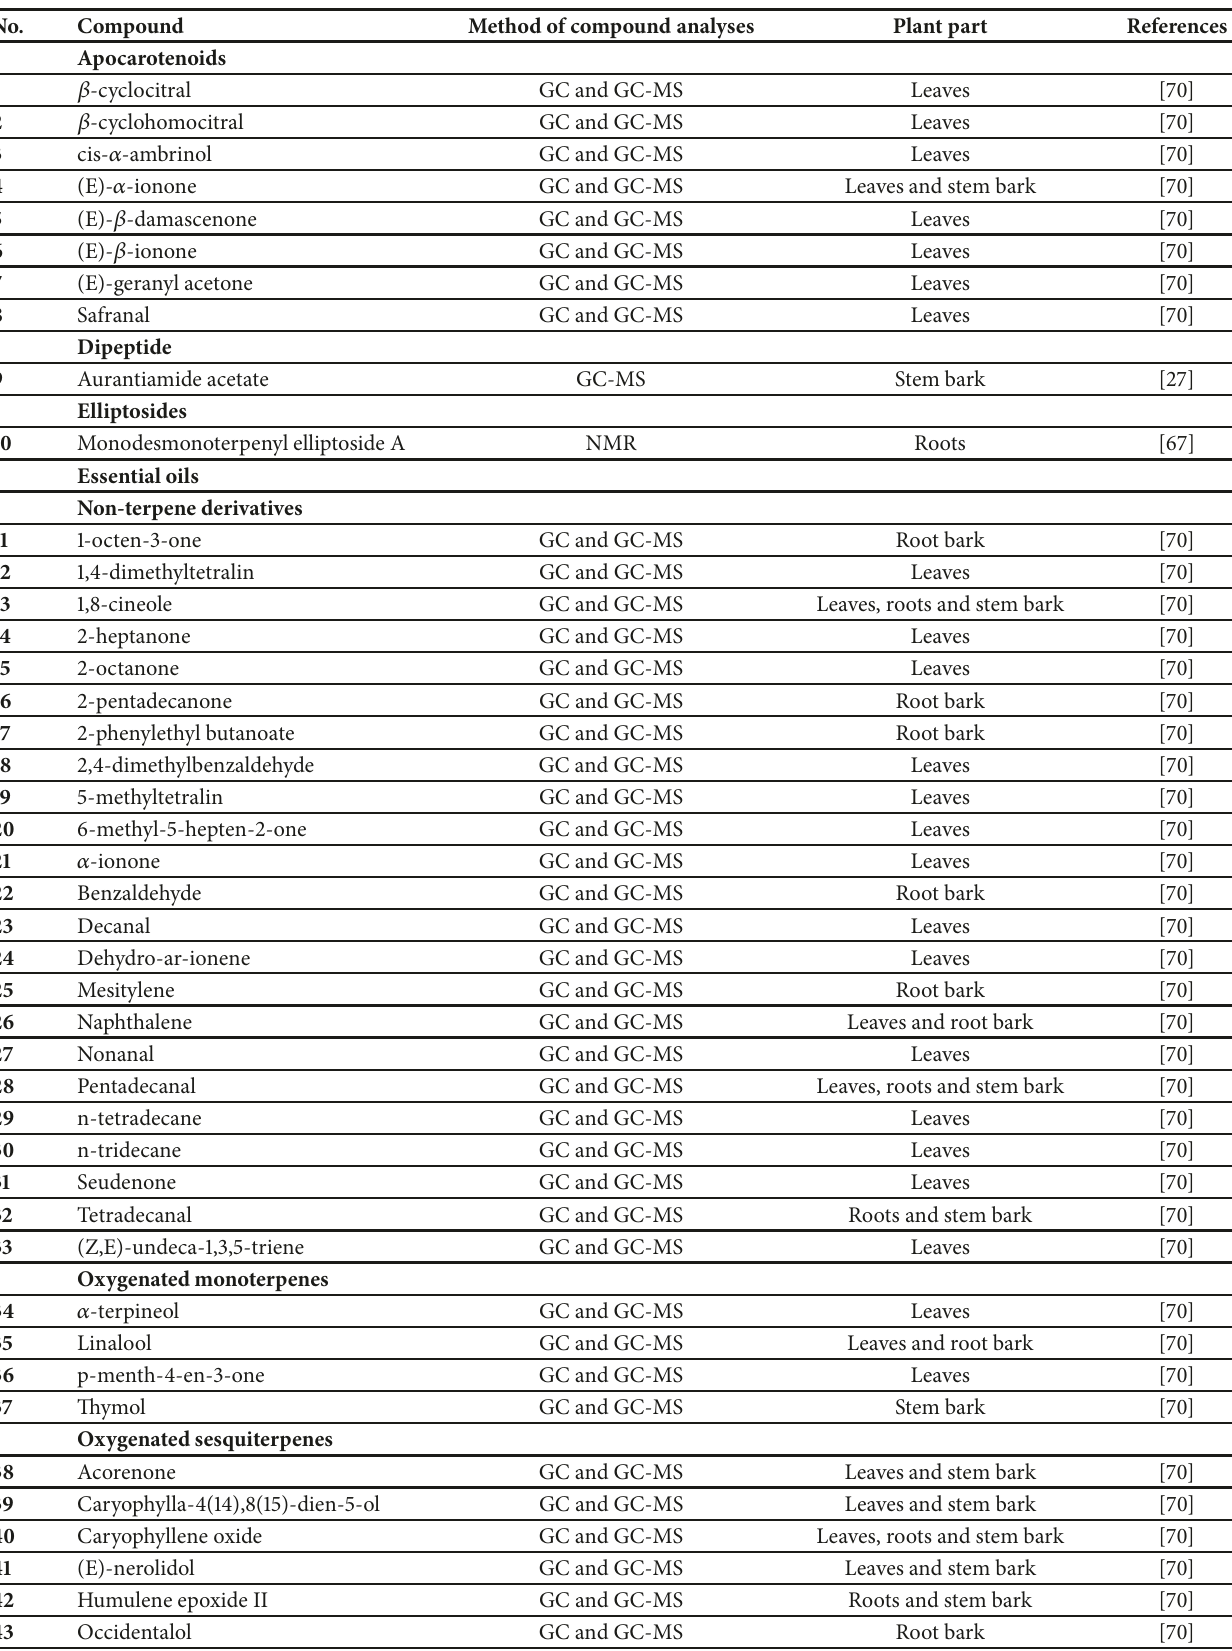
Table 2: Phytochemical compounds identified from Albizia